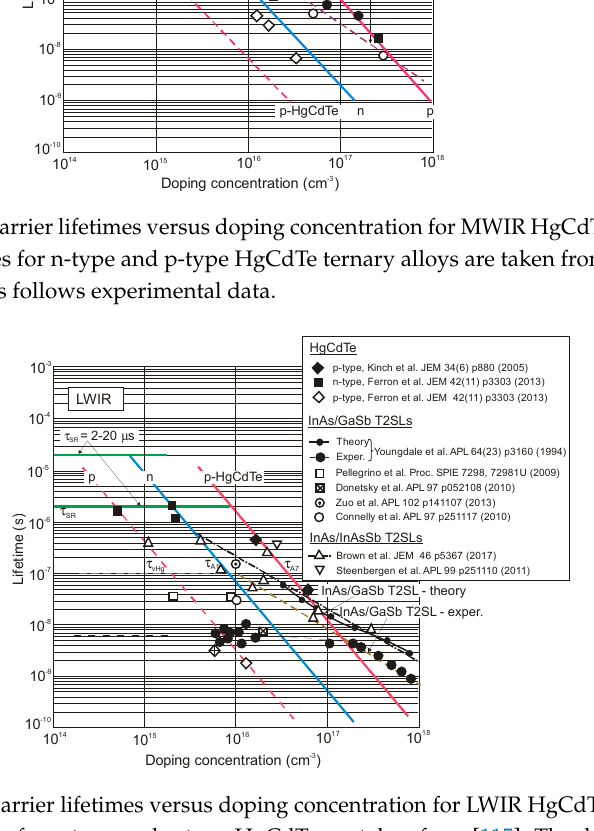
Figure 31. Minority carrier lifetimes versus doping concentration for LWIR HgCdTe and T2SLs at 77 K. Theoretical trend lines for n-type and p-type HgCdTe are taken from [115]. The dashed line for T2SLs follows experimental